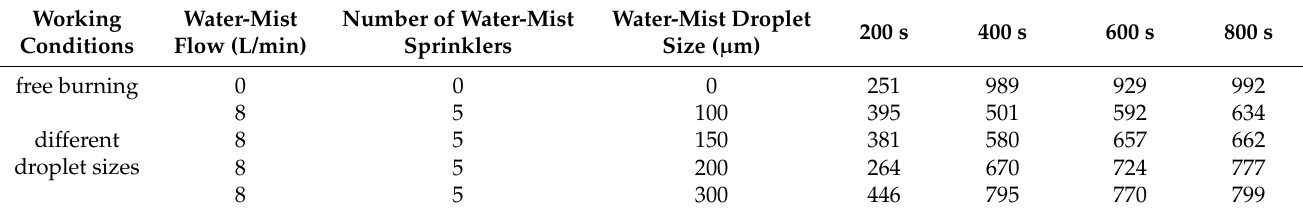
Table 4. Temperatures at 200, 400, 600, and 800 s at different droplet